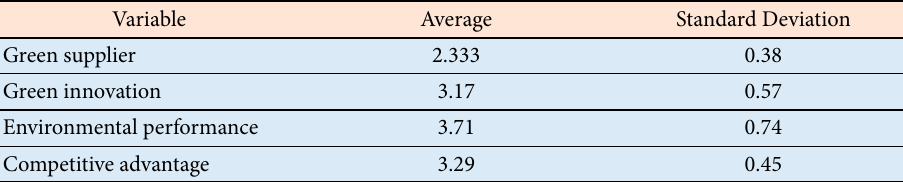
Table 2. Descriptive statistics of latent